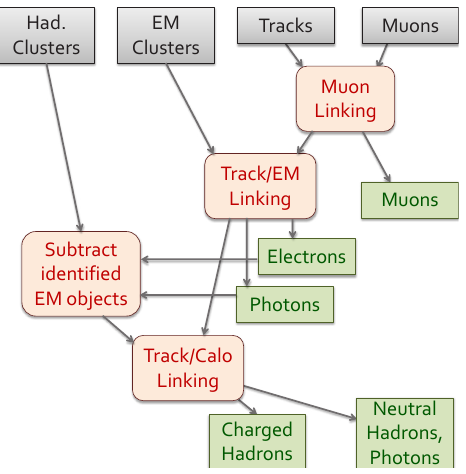
Figure 1. Data flow in the current prototype Level-1 PF algorithm. Gray boxes indicate the inputs from the di ff erent subsystems, tan boxes are the individual building blocks of the algorithm, and green boxes correspond to the output streams of PF objects (some of which also serve as input for further PF processing